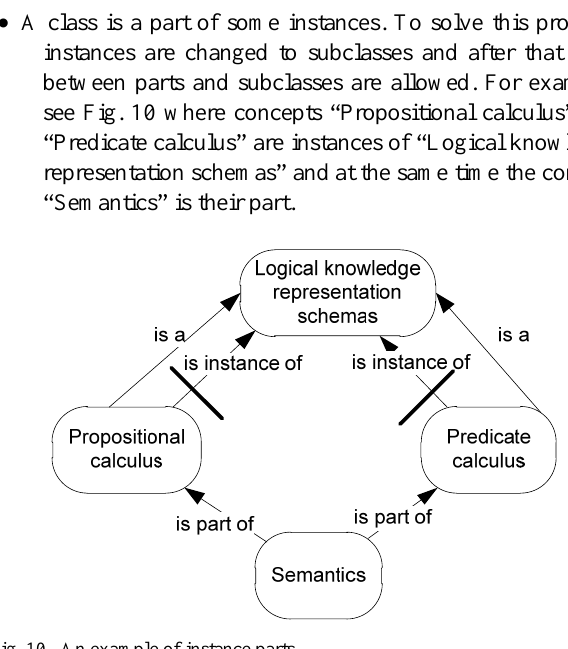
Fig. 10. An example of instance